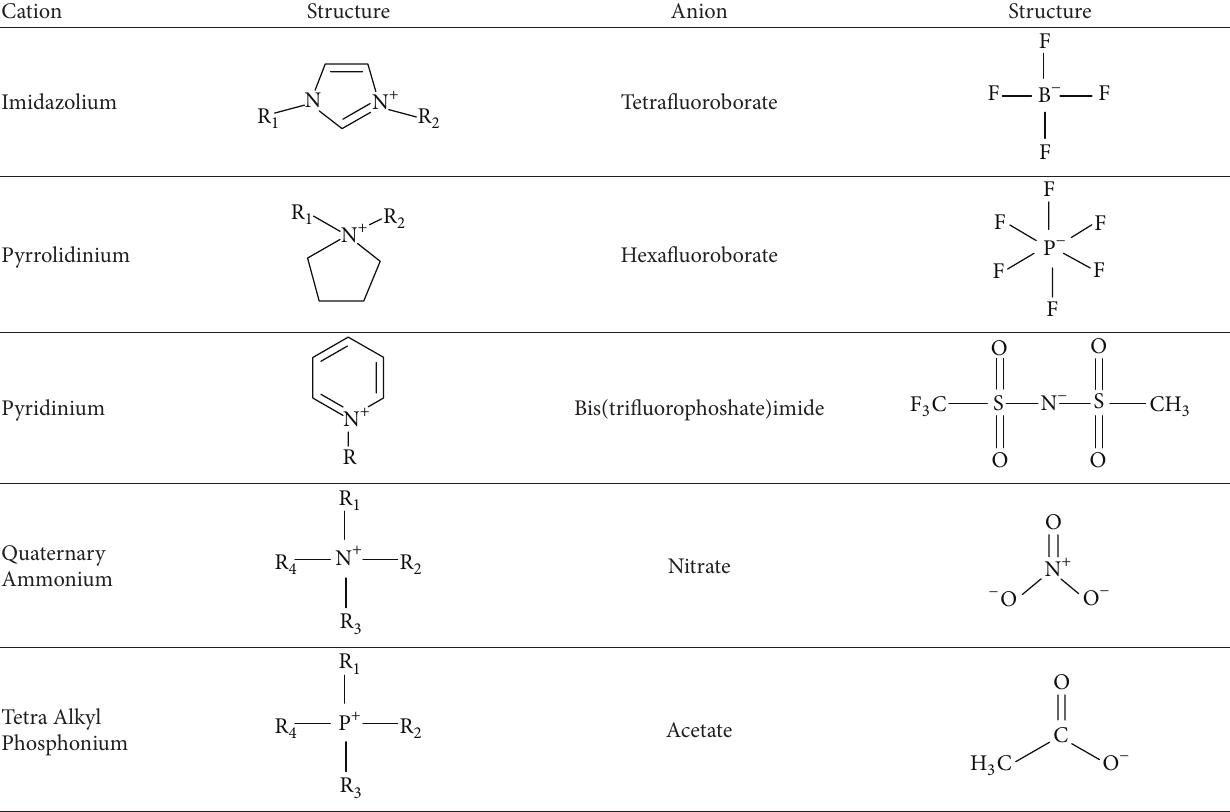
Table 2: Structures of common IL cations and